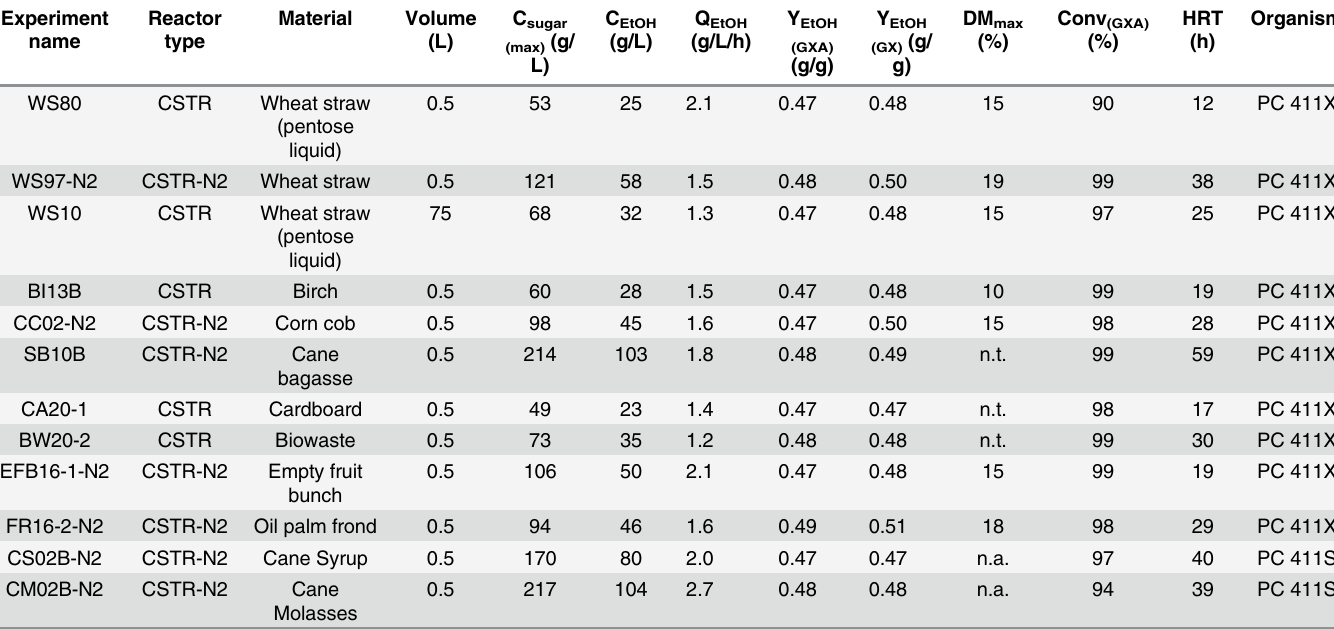
Table 2. Overview of results from continuous fermentations using Thermoanaerobacter Pentocrobe 411X and 411S. Experiment